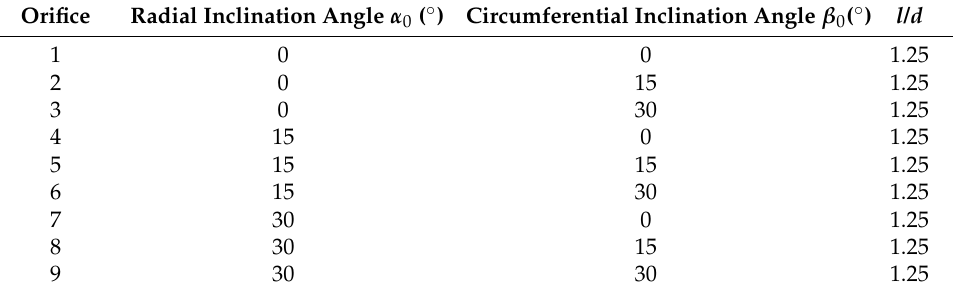
Table 2. Detailed parameter list of geometric model.